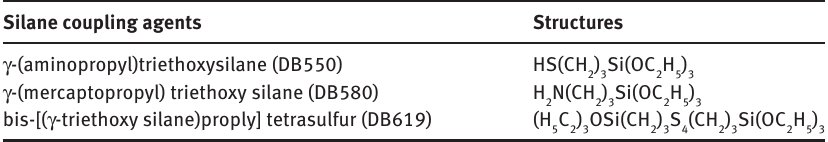
Table 1 Structures of coupling agent. Silane coupling agents Structures γ -(aminopropyl)triethoxysilane (DB550)